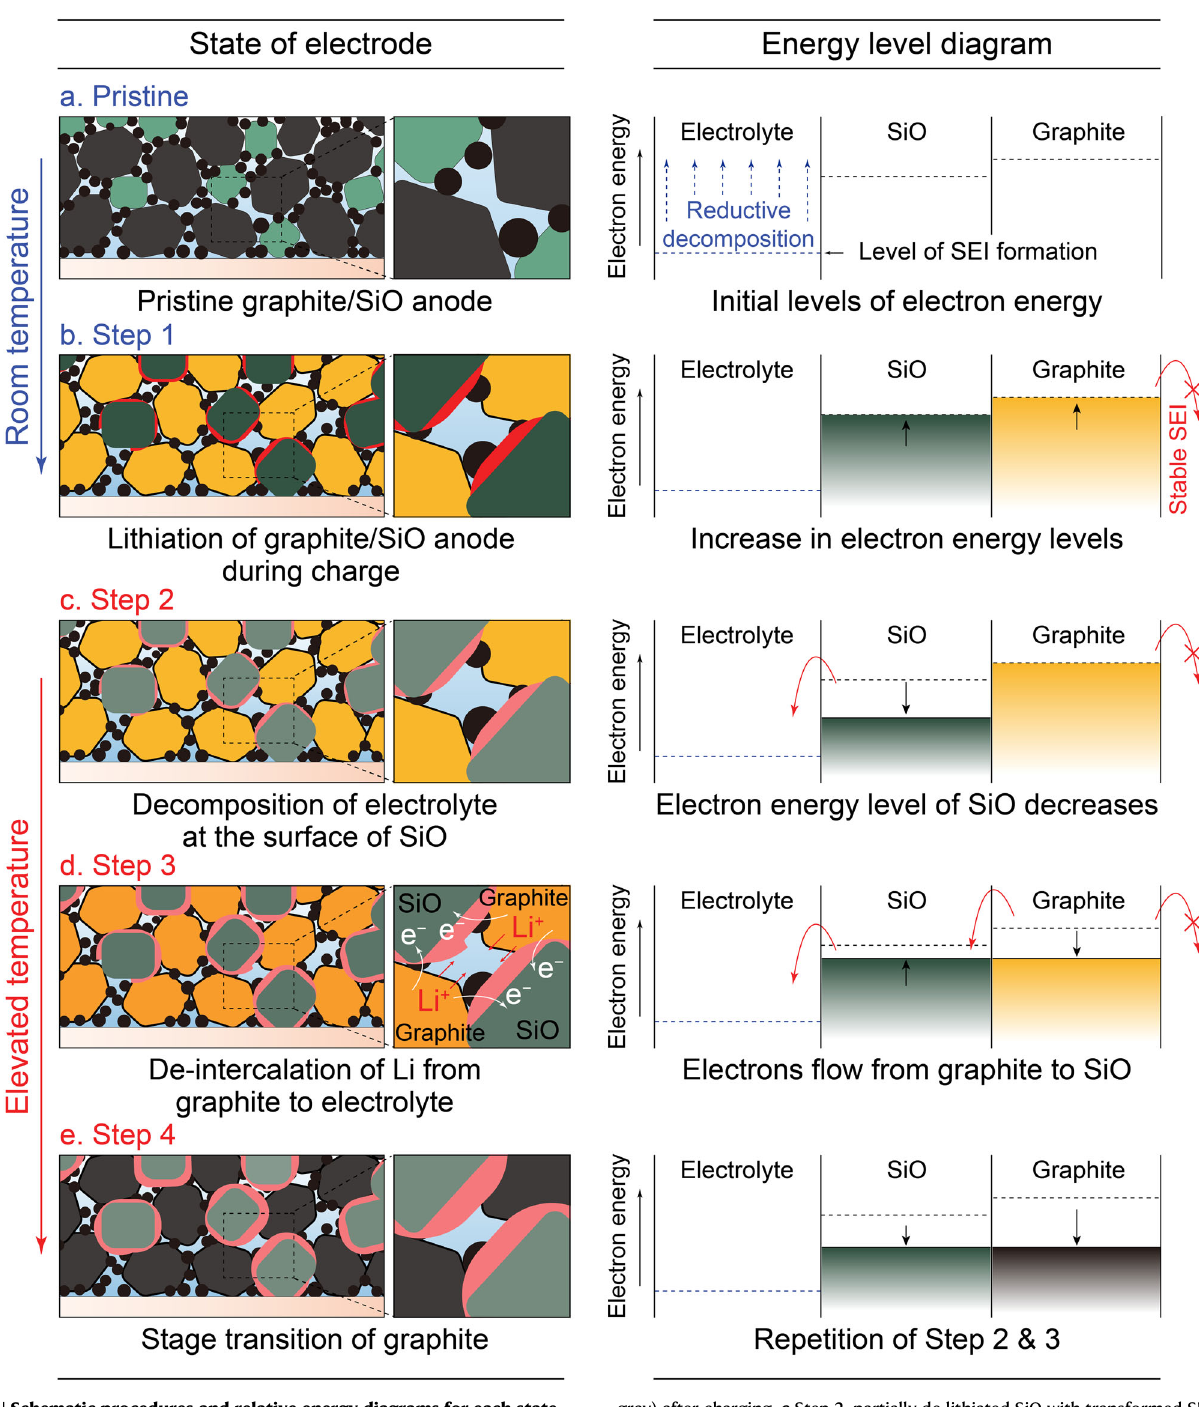
gray) after charging. c Step 2, partially de-lithiated SiO with transformed SEI after exposed to the elevated temperature. d Step 3, electron movement from graphite to SiO and concomitant lithium-ion de-intercalation from the graphite (orange). e Step 4, lithium exhaustion in the graphite (gray) upon prolonged thermal